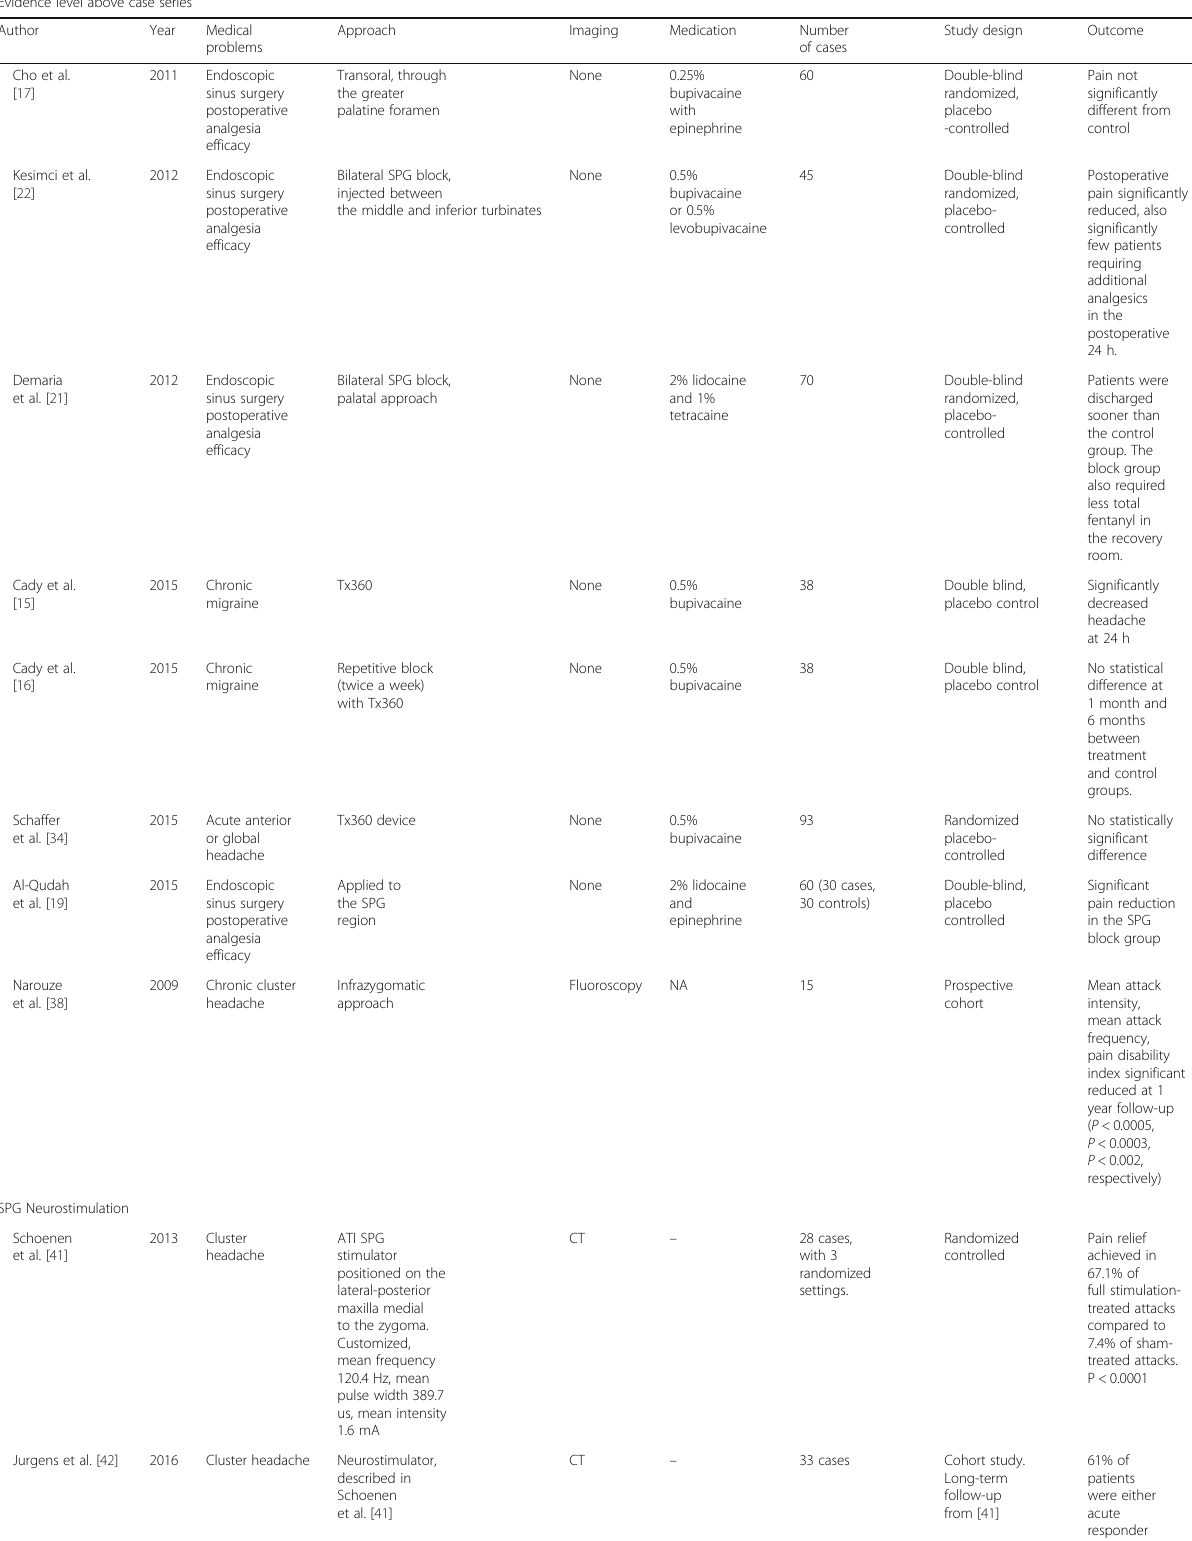
Table 2 Studies with evidence level above case series in SPG block, radiofrequency ablation and neurostimulation (Continued) Evidence level above case